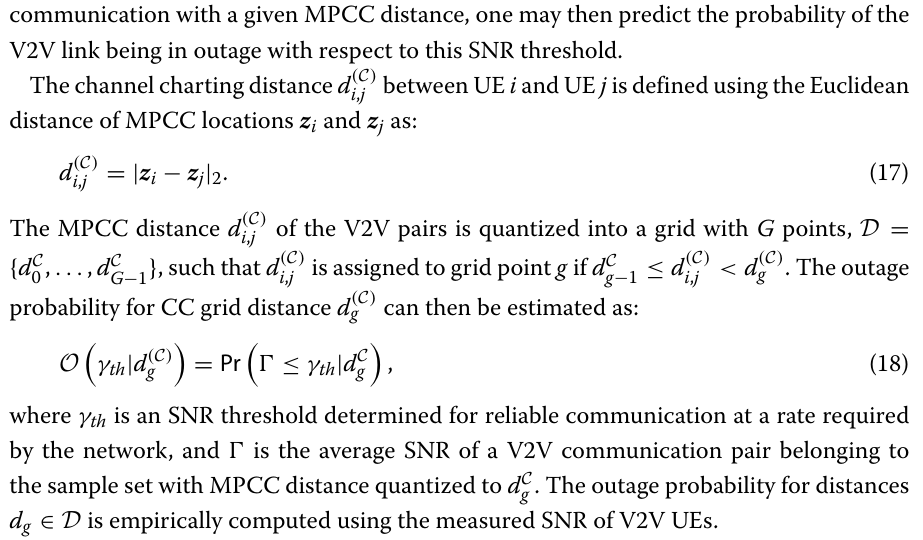
communication with a given MPCC distance, one may then predict the probability of the V2V link being in outage with respect to this SNR